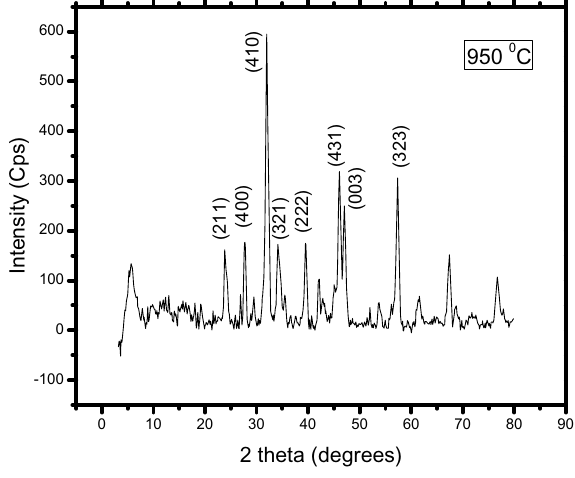
Fig. 1. XRD of Pb 2 Sr 2 CaCu 2 O 9 at 950 (cid:2)